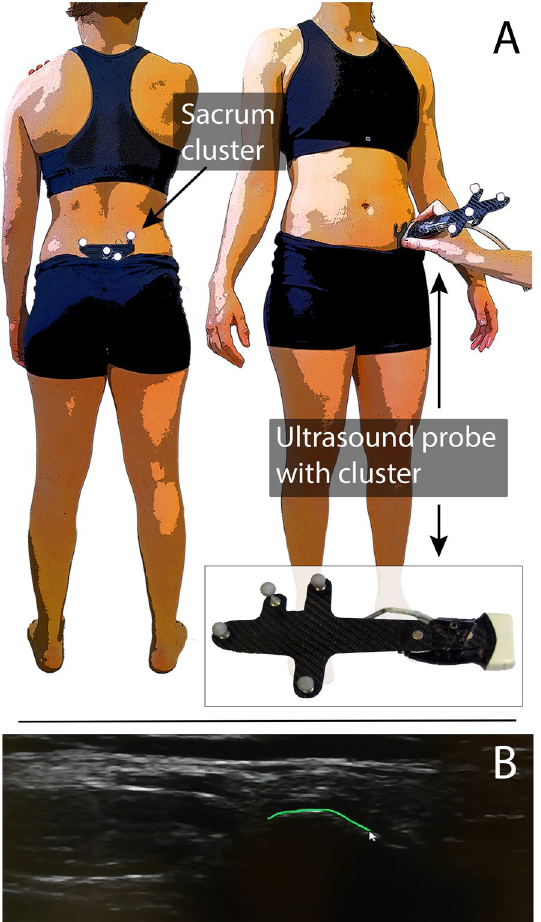
Figure 1. ( A ) The ultrasound probe was equipped with a marker-cluster to transform the image coordinates to the motion-capture coordinate system. A marker-cluster placed at the sacrum of the participants served as the local reference system. ( B ) This image illustrates how the pixel coordinates of the bone surface, in this case of the anterior superior iliac spine (ASIS), in each ultrasound image were manually digitized. Note that for the identification of the ASIS location the most anterior point was selected manually.